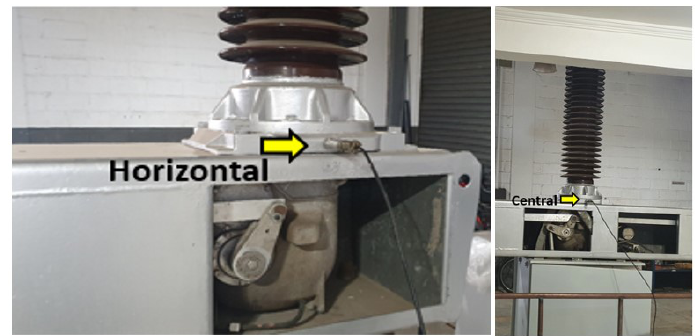
Figure 4. Installed